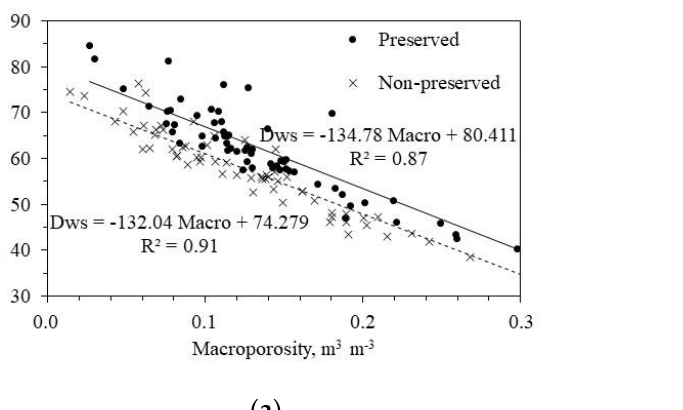
Figure 7. Regression between physical properties for soil with preserved and non-preserved struc- ture. Bdi = bulk density in the beginning of the uniaxial compression test; Dws = degree of water saturation; Ci = compressibility index.